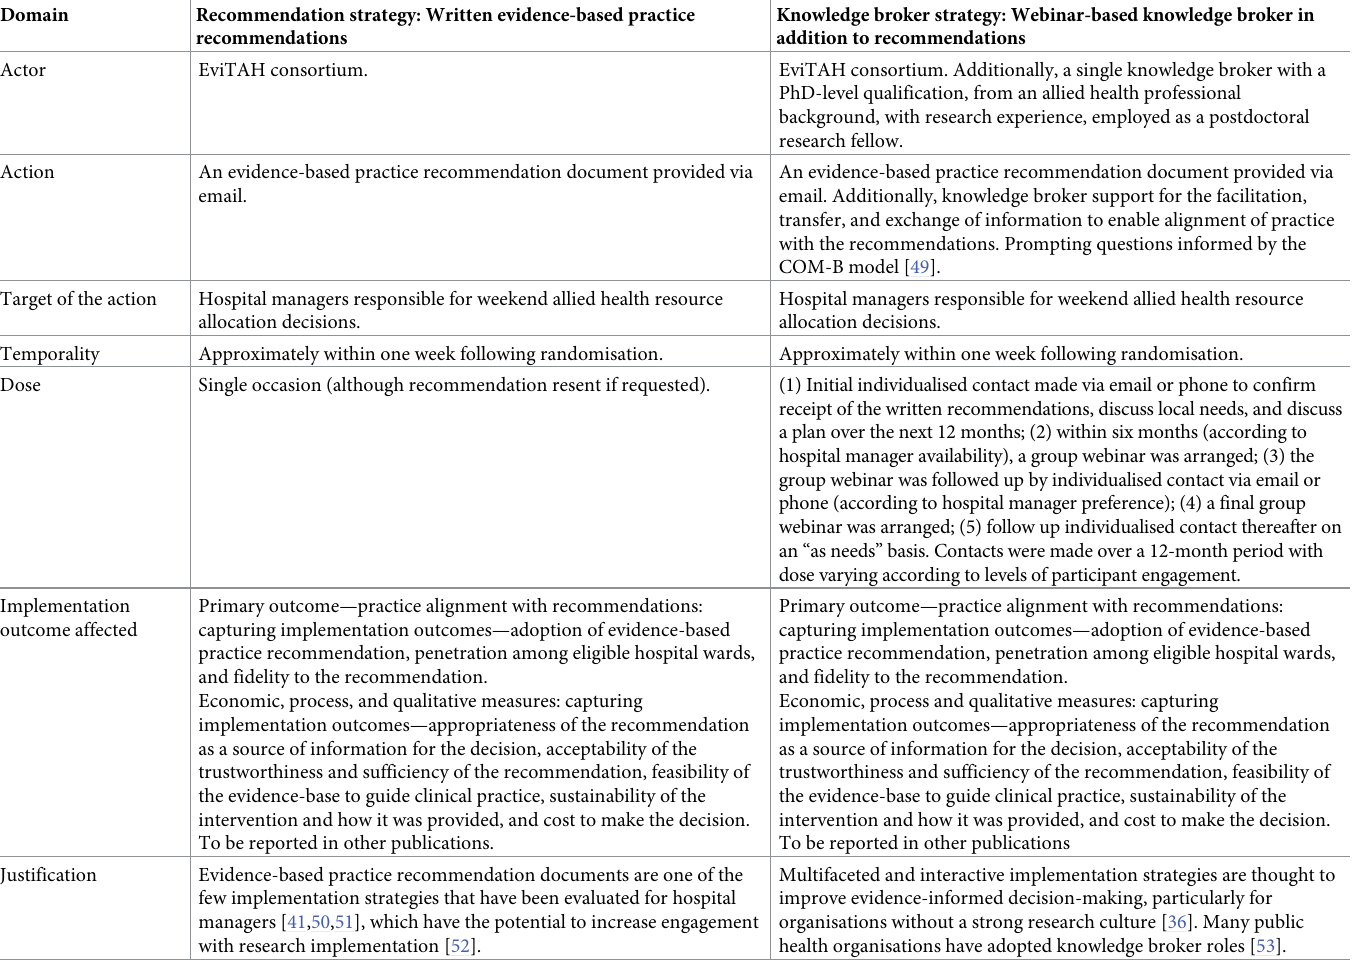
Table 1. Specification and reporting of each implementation